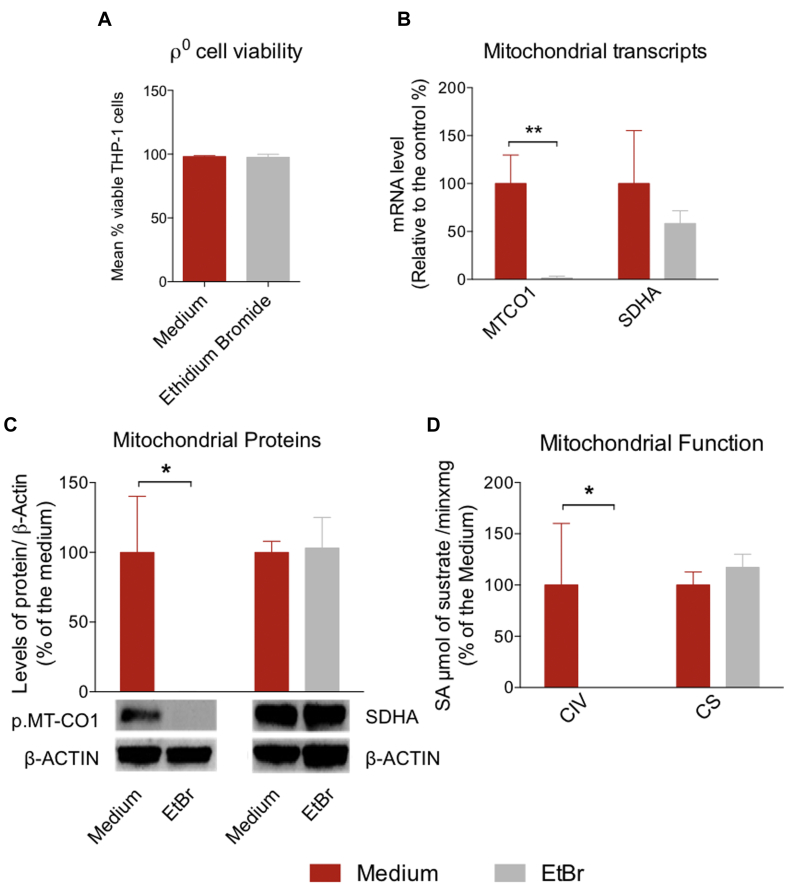
Effects of mtDNA depletion on THP-1 cells. THP-1 cells were treated with 50 ng/mL EtBr for 8 weeks. A, Cell viability. B, Mitochondrial transcripts. C, Mitochondrial proteins relative to β-actin. D, Spectrophotometric measurements of isolated respiratory enzyme activity in cellular homogenates for complex IV (CIV) and citrate synthase (CS) activity. All experiments had 3 independent biological replicates and are presented as means ± SD. *P < .05 and **P < .01.